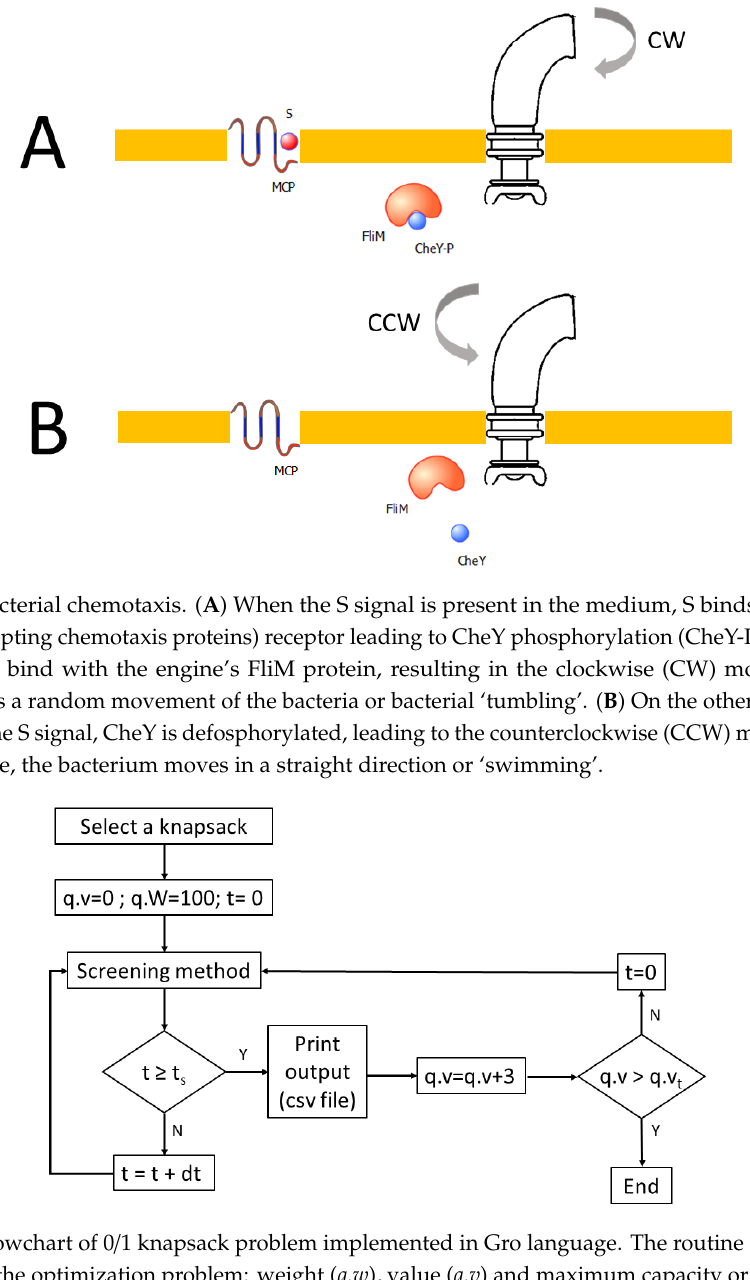
Figure 7. Flowchart of 0 / 1 knapsack problem implemented in Gro language. The routine records three variables of the optimization problem: weight ( q.w ), value ( q.v ) and maximum capacity or weight ( q.W ) of the knapsack. Next, the algorithm calls the screening routine, saving the output in a csv file once the time of the simulation reaches the imposed limit ( t s ). Afterwards, the q.v value is updated (i.e., 3 units) and in the case that the resulting value is greater than the sum of all the knapsack values ( q.v t ), then the Gro routine ends. Otherwise, when the condition is not satisfied, the new q.v is evaluated by the screening method again. Eventually, the output file will contain the value of a set of items q.v (i.e., x i ) and its fitness (i.e., y i ) for all the possible combinations .